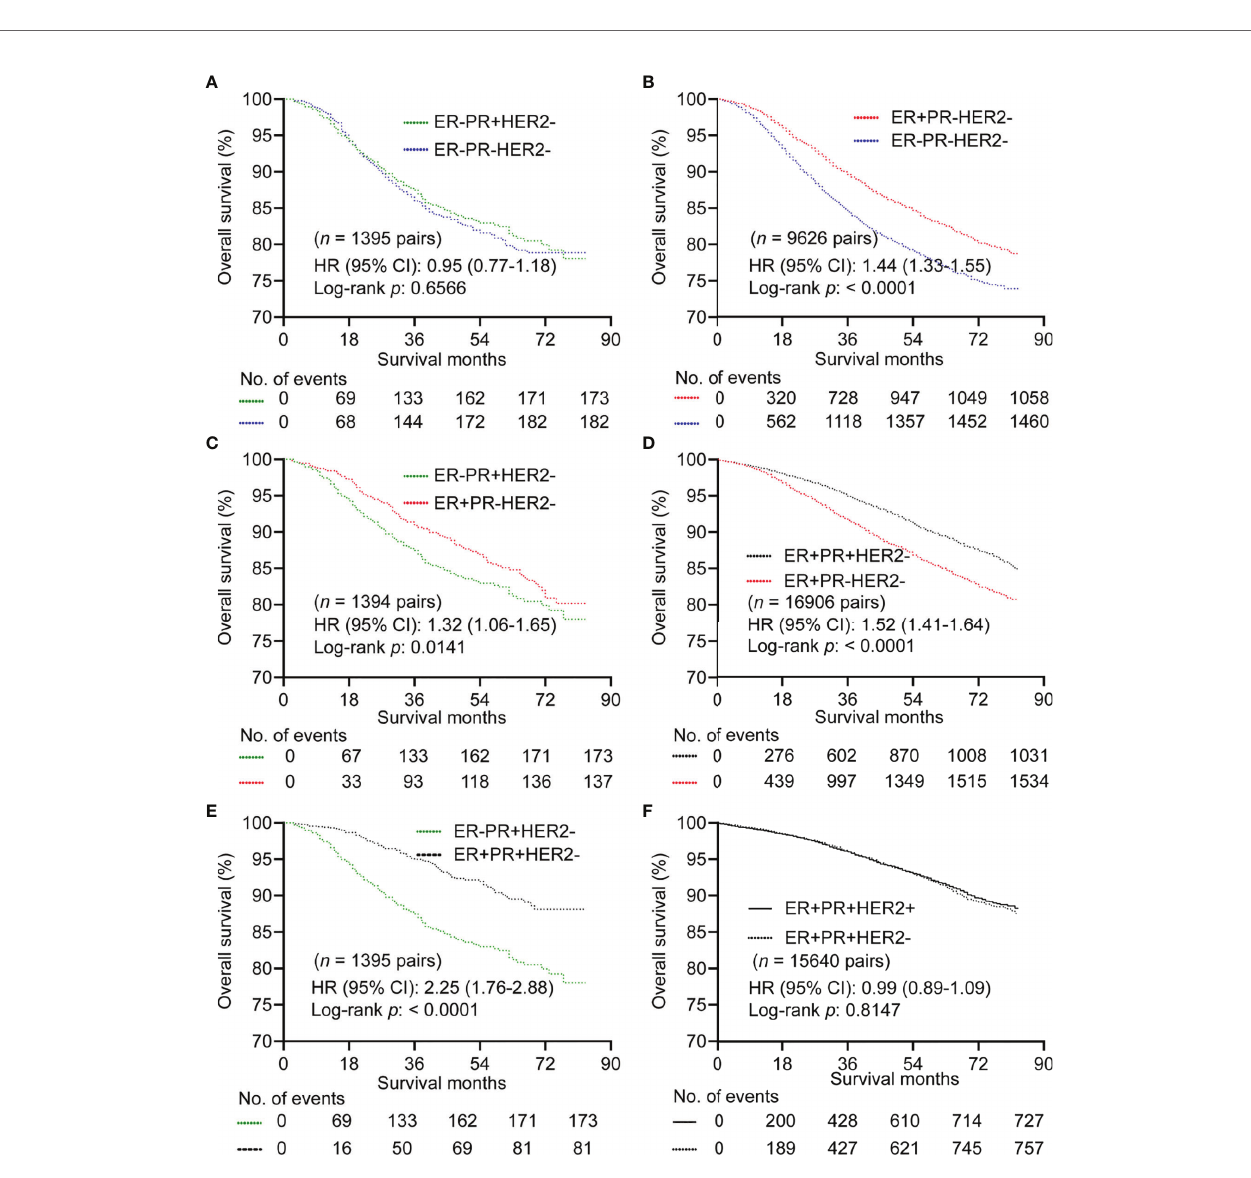
FIGURE 2 | Kaplan – Meier curves of overall survival after propensity score matching in HER2- subgroup. (A) Comparison between ER-PR+ and ER-PR-. (B) Comparison between ER+PR- and ER-PR-. (C) Comparison between ER-PR+ and ER+PR-. (D) Comparison between ER+PR+ and ER+PR-. (E) Comparison between ER+PR+ and ER-PR+. (F) Comparison between ER+PR+HER2- and ER+PR+HER2+. ER, estrogen receptor; PR, progesterone receptor; HER2, human epidermal growth factor Receptor